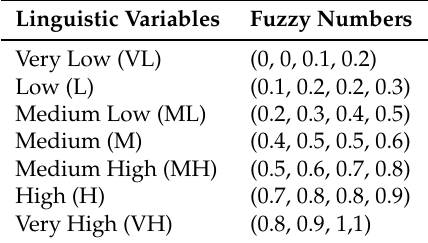
Table 5. Linguistic variables for evaluating the weights of risk factors.